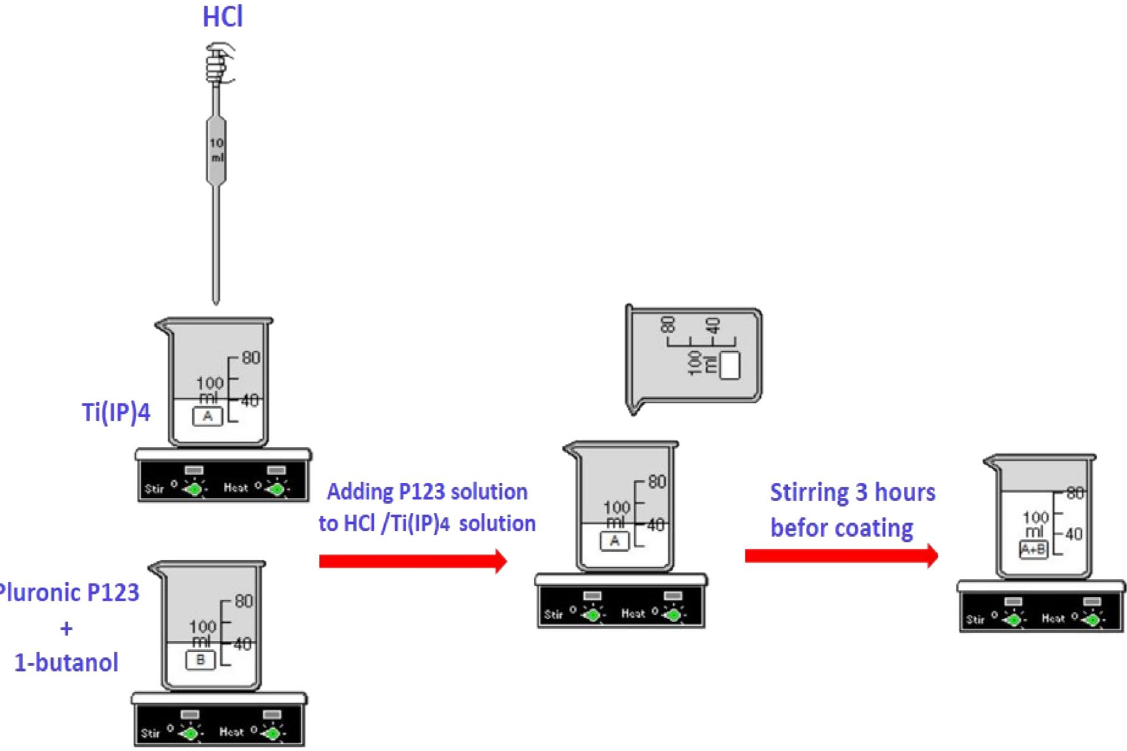
Figure 9. Scheme of the preparation procedure for